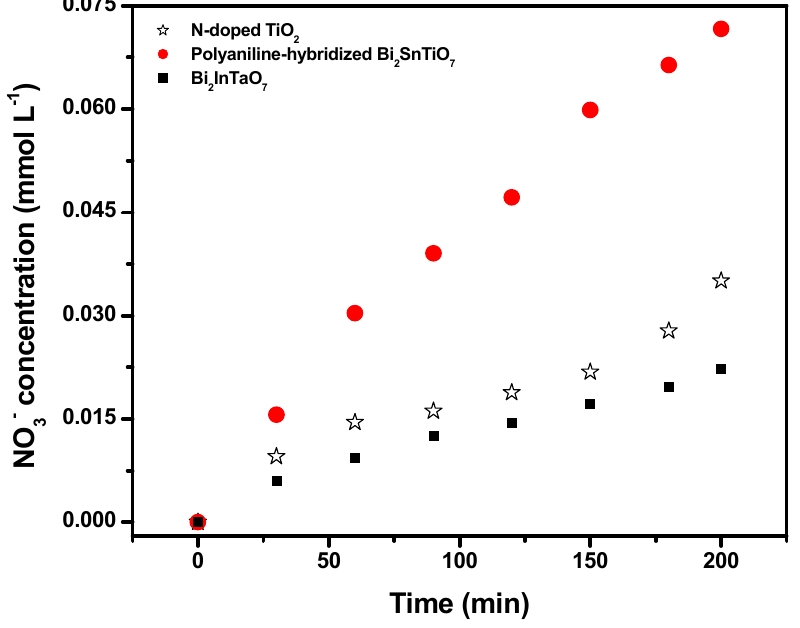
Figure 8. The concentration variation of NO methylene blue with the polyaniline-hybridized Bi catalyst under visible light